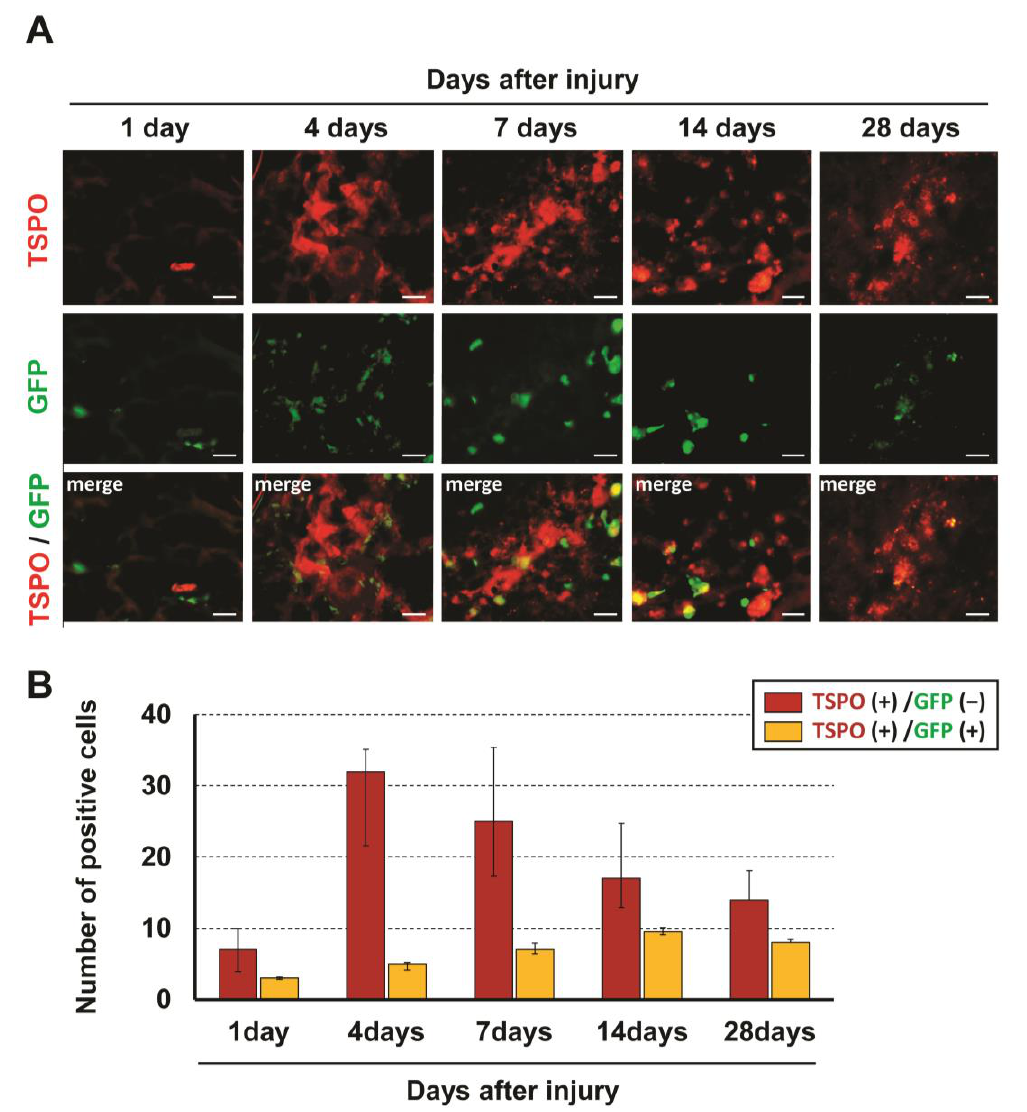
Figure 2. Immunofluorescent staining showing GFP-positive/TSPO-positive and GFP-nega- tive/TSPO-positive cells at the injured site at 1, 4, 7, 14 and 28 days after SCI ( A ). The number of TSPO- positive cells at the injured site peaked at 4 days after SCI and significantly fewer TSPO-positive cells merged with GFP over time ( B ). Scale bars = 20 µ